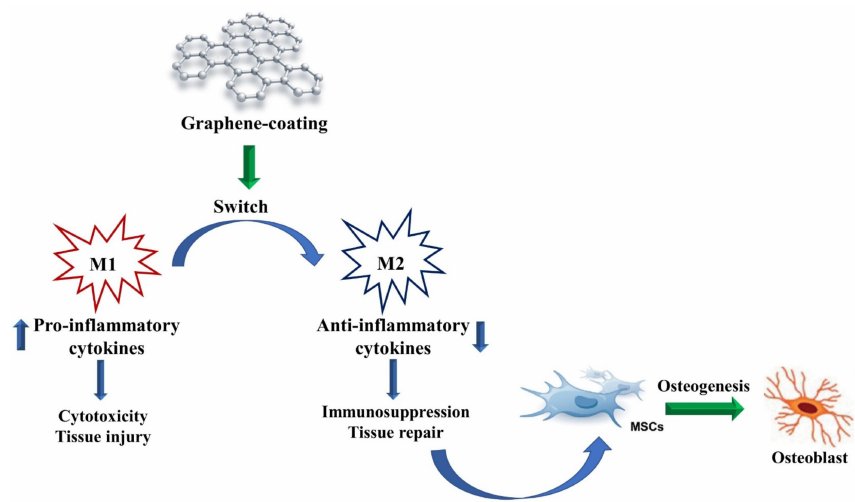
Figure 4. Effect of graphene on the immune system. Under the influence of graphene-coated materials, macrophages change their phenotype from the pro-inflammatory M1 to the anti-inflammatory M2 one, promoting tissue repair (osteogenesis). MSCs = mesenchymal stem